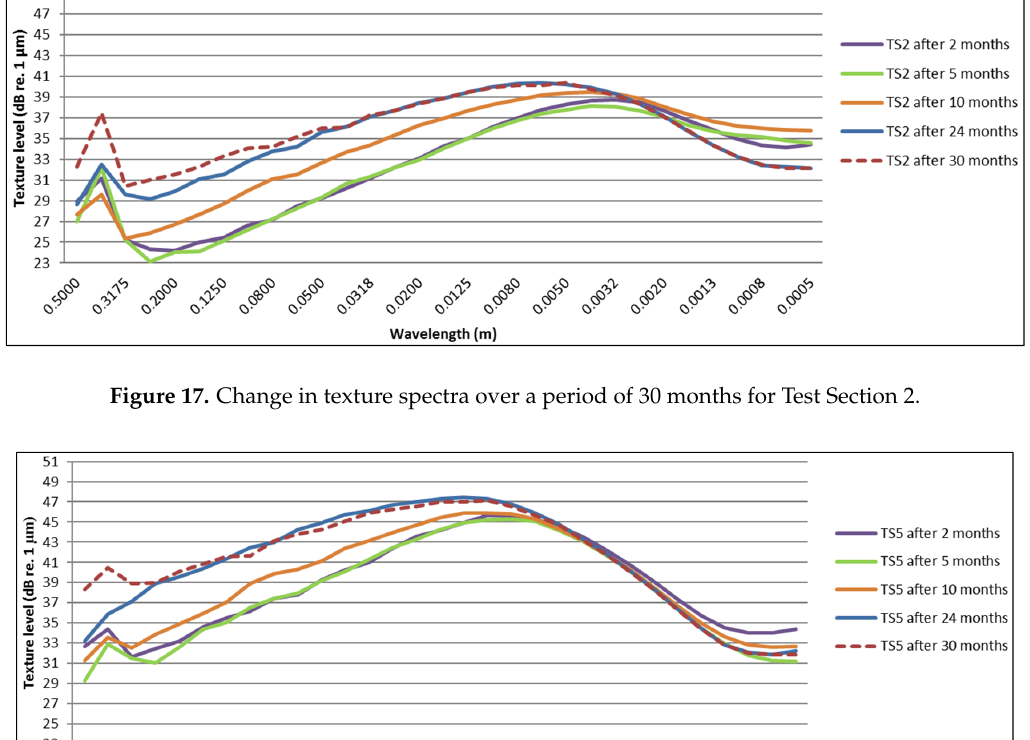
Figure 18. Change in texture spectra over a period of 30 months for Test Section 5 (DPAC).